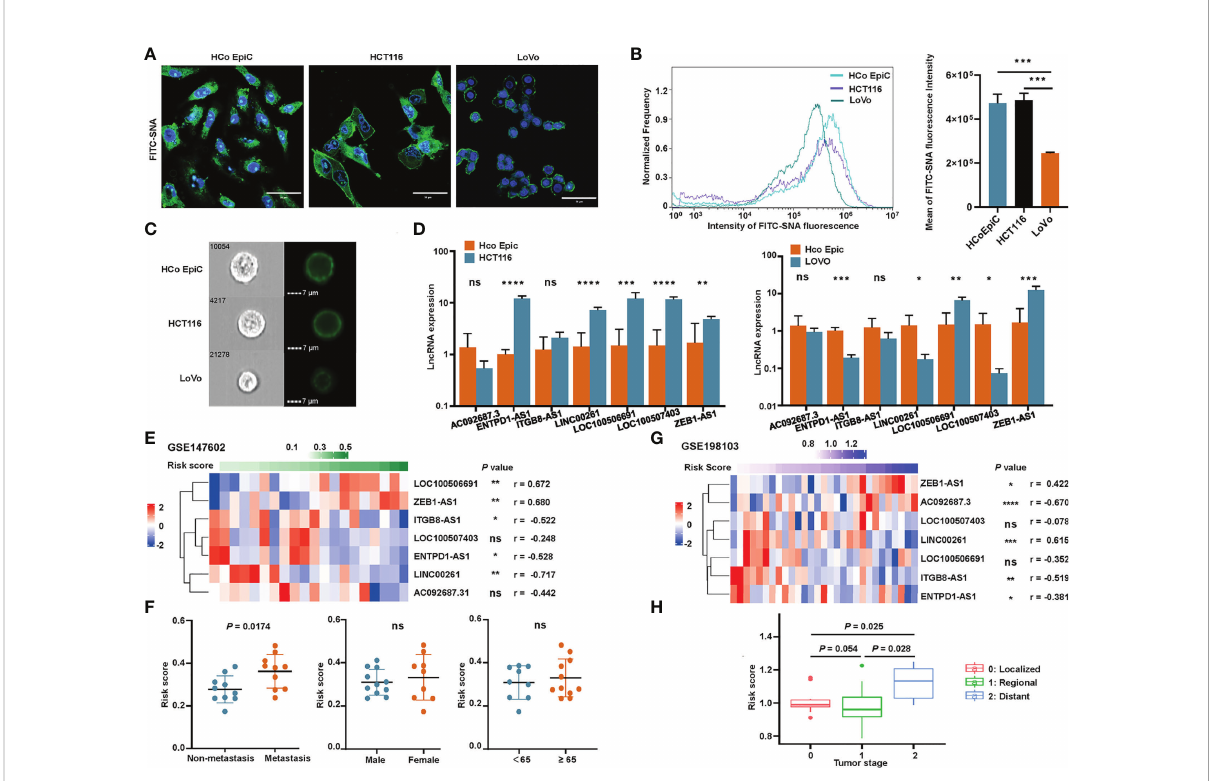
FIGURE 10 Validation of the sialylation-related lncRNA signature. (A) Representative confocal images of normal human colonic epithelial cells (HCoEpiC) and colonic cancer cells including HCT116 and LoVo stained with FITC-SNA. (B) Flow cytometry histogram and boxplot showing the a 2 ’ -6 ’ - sialylation on the surface of the three cell types. (C) Representative images of the three cell types photographed by Image-Stream MarkII. (D) Comparison of the seven lncRNAs between HCoEpiC, HCT116 cells, and LoVo cells. (E) Expression pro fi le of the lncRNAs in GSE147602. (F) Risk score distribution in GSE147602 with different clinical features. (G) Expression pro fi le of the lncRNAs in GSE198103. (H) Risk score of patients with different tumor stages in GSE198103. **** P < 0.0001; *** P < 0.001; ** P < 0.01; * P < 0.05; and ns, not signi fi